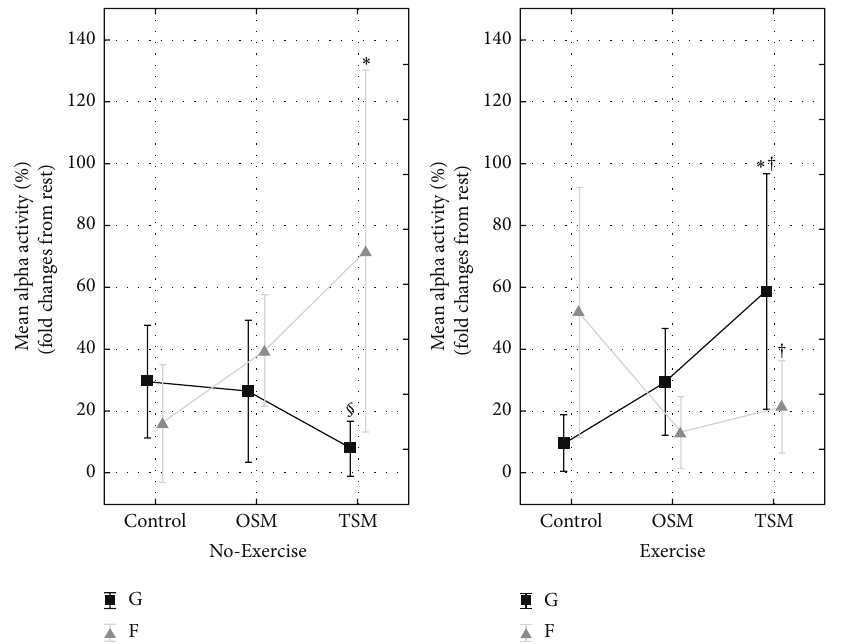
Figure 3: Mean alpha activity (7.5–12.5 Hz), expressed as relative (%) changes over global (G; black lines) and frontal (F; grey lines) electrode sites.MeanEEGactivitywasmeasuredbefore(rest)andfollowingNo-Exercise(automaticdrive)andExercise(moderatecycling)trialswithin three levels of virtual environment exposure (Control; OSM: one-screen mode; TSM: three-screen mode). ∗ indicates a significant difference compared with Control ( 𝑝 < 0.05 ); † indicates difference between Exercise and No-Exercise trials ( 𝑝 < 0.05 ); § indicates difference between F and G ( 𝑝 < 0.05 ). Data are mean ± 0.95 CI ( 𝑛 = 18 ).